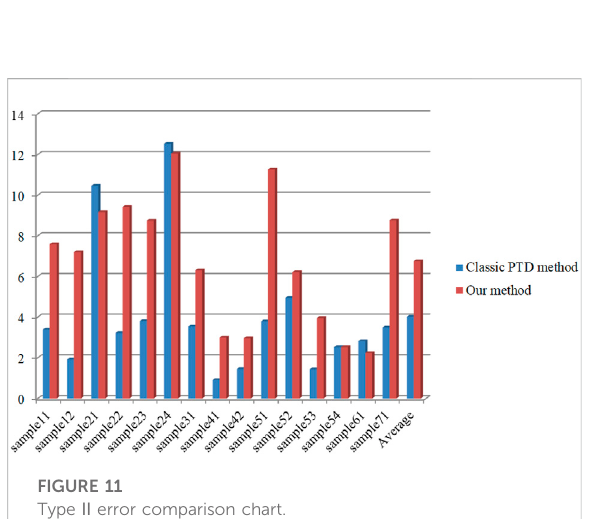
FIGURE 10 Type I error comparison